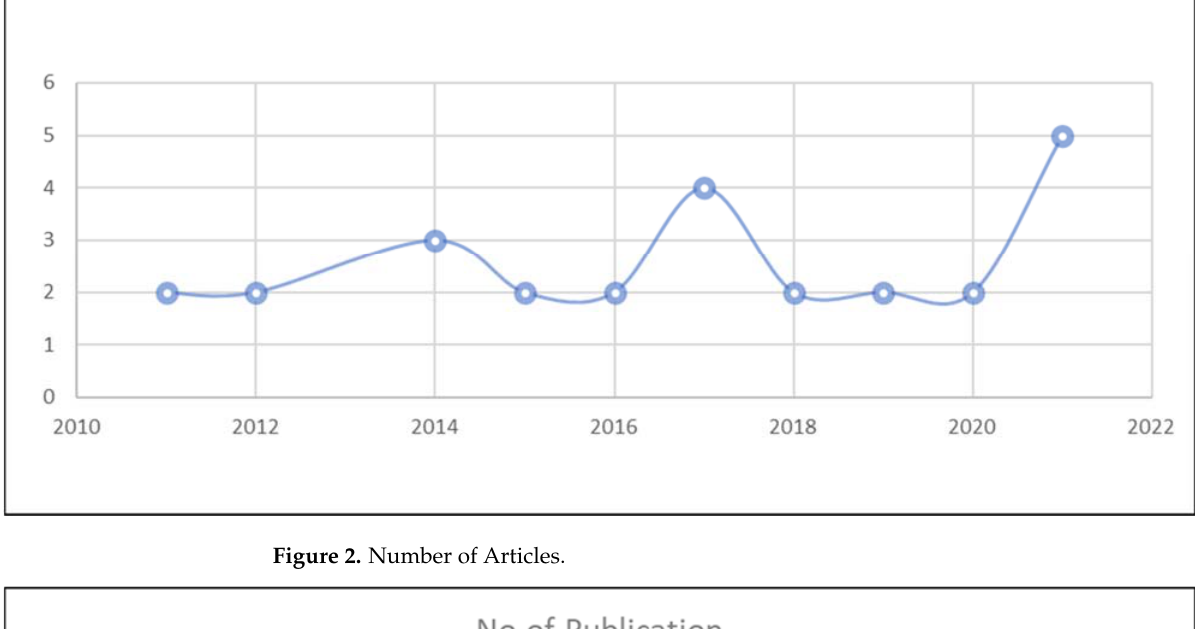
Figure 2. Number of Articles.